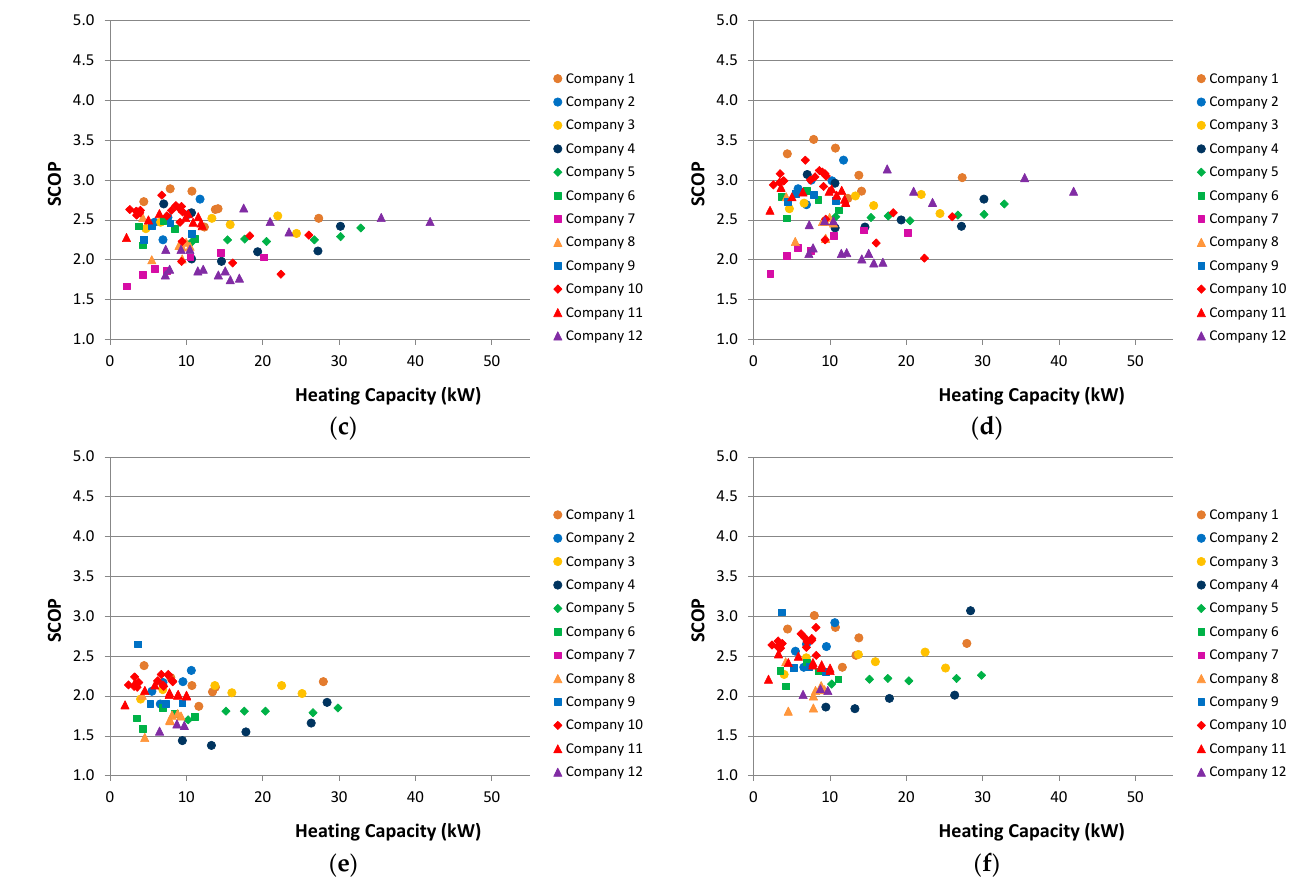
Figure 6. SCOP against HP’s heating capacity for the city of Florina: ( a ) Τ w,outlet = 35 °C—without compensation, ( b ) Τ w,outlet = 35 °C—with compensation, ( c ) Τ w,outlet = 45 °C—without compensation, ( d ) Τ w, outlet = 45 °C—with compensation, ( e ) Τ w,outlet = 55 °C—without compensation, ( f ) Τ w,outlet = 55 °C—with compensation.